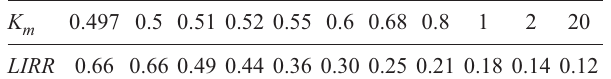
Table 1 . Dependence of the logistic internal rate of return on the amount of resources K